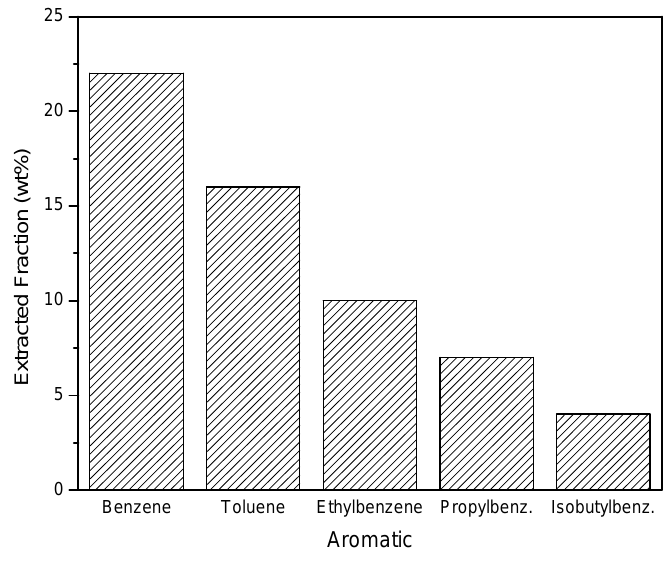
Figure 6. Effect of the alkyl substituents of the benzene ring on the extraction of aromatic compounds from n -octane (10 wt % solution of benzene in n -octane) by BMI.N(Tf) (IL:benzene ratio of 1:1, 2 mol/mol; 1 ml of